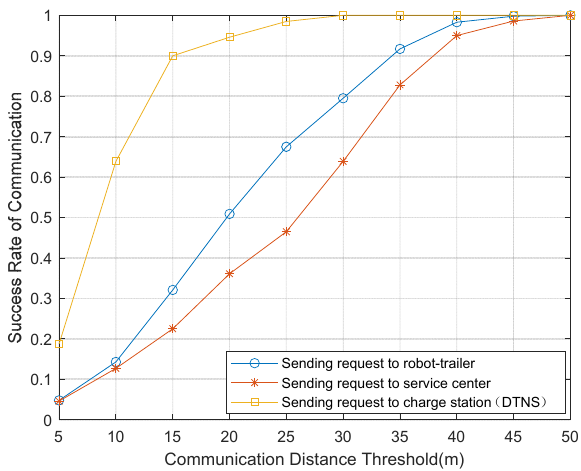
Figure 6. Comparison of success rates of communication when the locations of charging stations are randomly distributed in the service space.